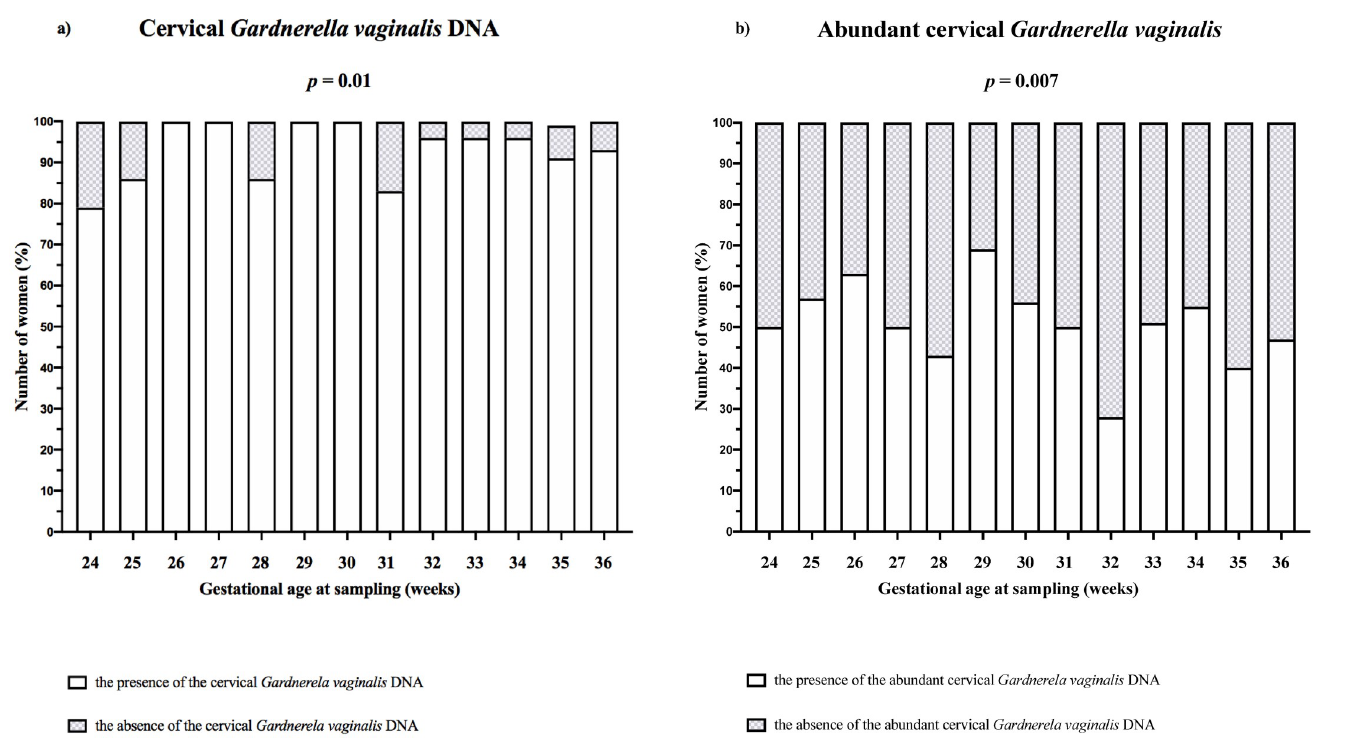
Fig 1. The rates of the presence of G . vaginalis DNA (a) and the presence of abundant cervical G . vaginalis (cervical microbial loads of G . vaginalis DNA � 1% of amount of the cervical bacterial DNA; (b) according to gestational age at PPROM. Differences among gestational ages at sampling (weeks) and the rates of the presence of G . vaginalis DNA ( p = 0.01) and abundant cervical G . vaginalis DNA ( p = 0.007) were observed.